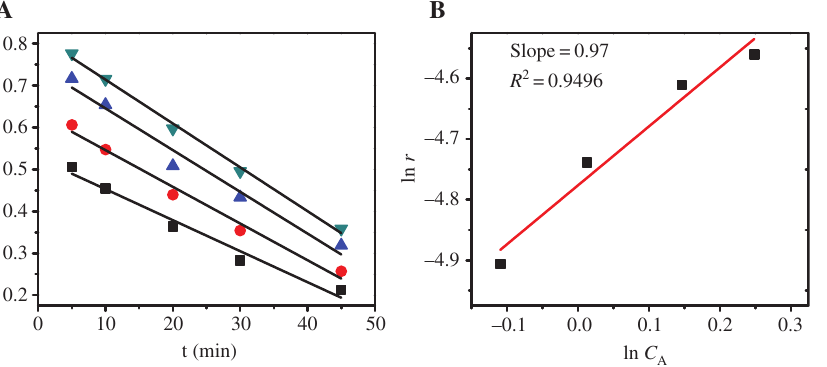
) versus reaction time; symbols for initial C values: 1.28 ( ▼ ), 1.16 ( ▲ ), 1.01 (●), A A . Reaction conditions: temperature 393 K; initial H A